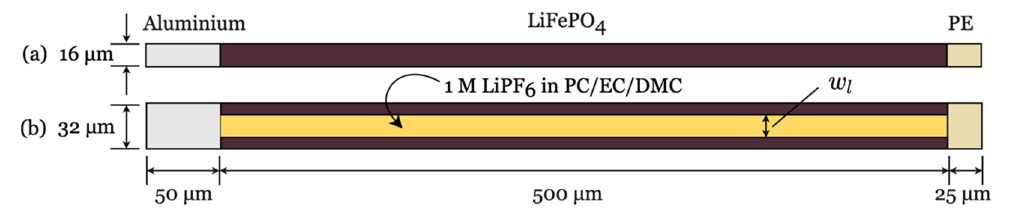
Figure 2. Schematic view of the geometric cell development with ( a ) a single structure and ( b ) an ideal lamellar structure with an electrolyte channel width w l . The single structure is comparable to most model designs and represents a solid electrode with an inner porous structure as shown in Figure 1.